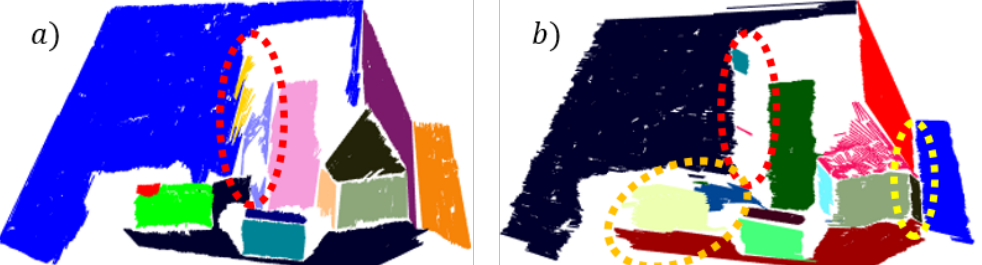
Figure 23. Red ellipse marks occluded sparse area which is over-segmented in vertical clustering ( a ) and almost completely removed in horizontal clustering ( b ). The floor is over-segmented due to occlusion caused by the object marked with orange ellipsis. Yellow ellipsis marks the part of the over-segmented red wall, as a result of blurred